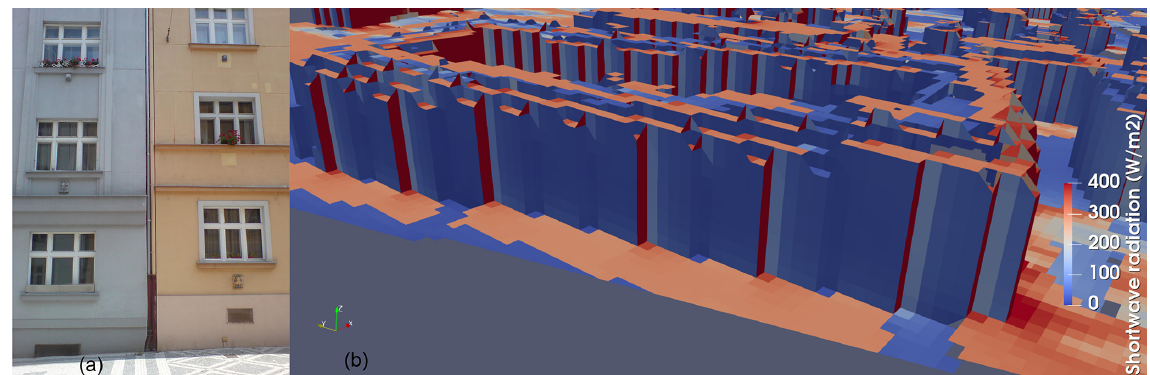
Figure 23. West-facing wall in N. A. Nˇekrasova Street around location 07-2_V (see Fig. 1 and the detailed location information in Supplement Sect. S3). The figure shows the observed photo on 20 July 2018 at 10:37UTC (left) and the 3D view of the modelled incoming SW radiation on this wall at the corresponding modelling time step